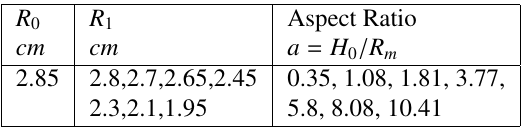
Table 2. Internal lower and upper radius of the granular columns and the respective aspect ratios used in